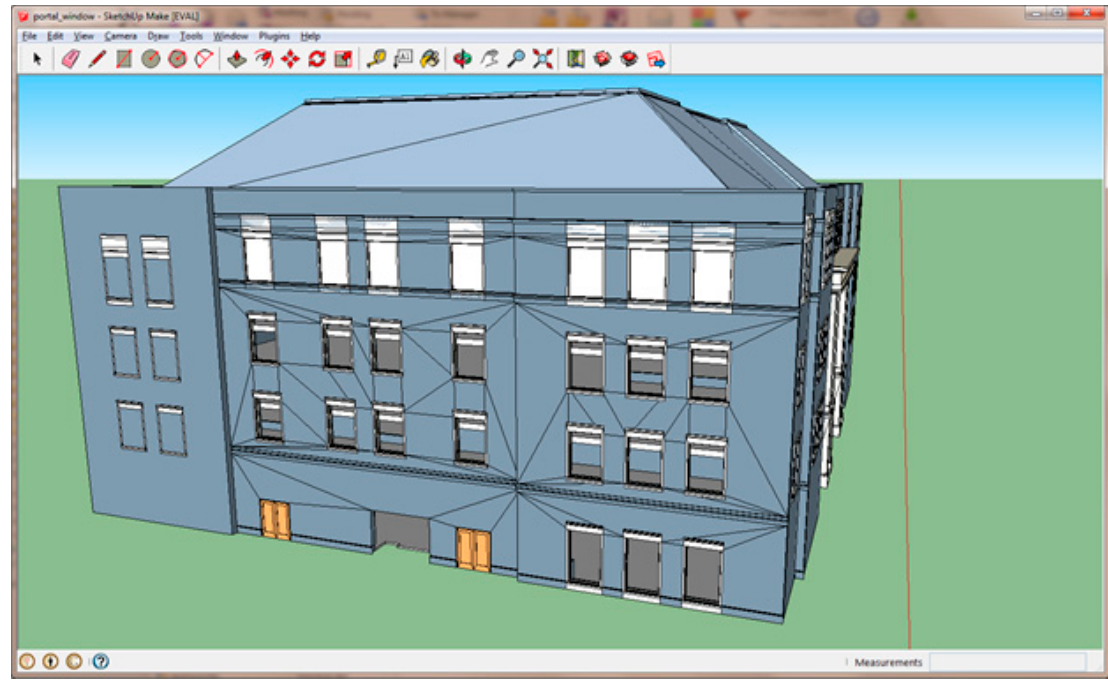
Figure 3. Window 3D representation and properties reproduced using Industry Foundation Class (IFC) data exchange.